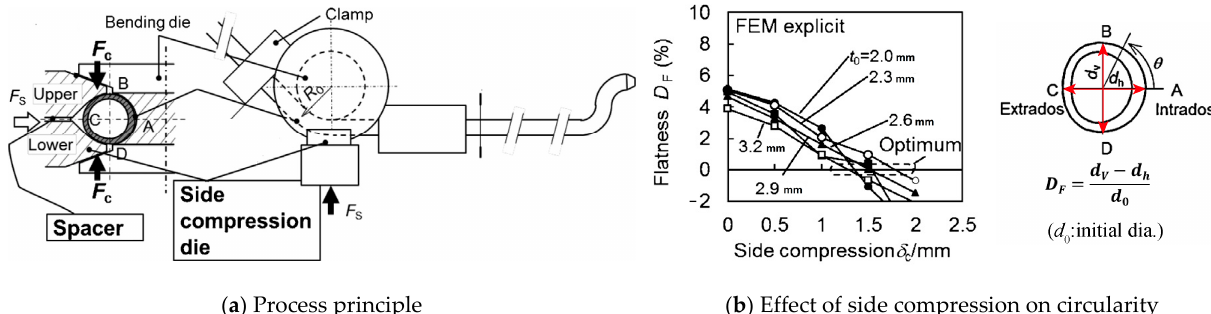
Figure 8. Side compression bending of profiles. Reproduced with permission from ref. [36]. Copyright 2013 CIRP.